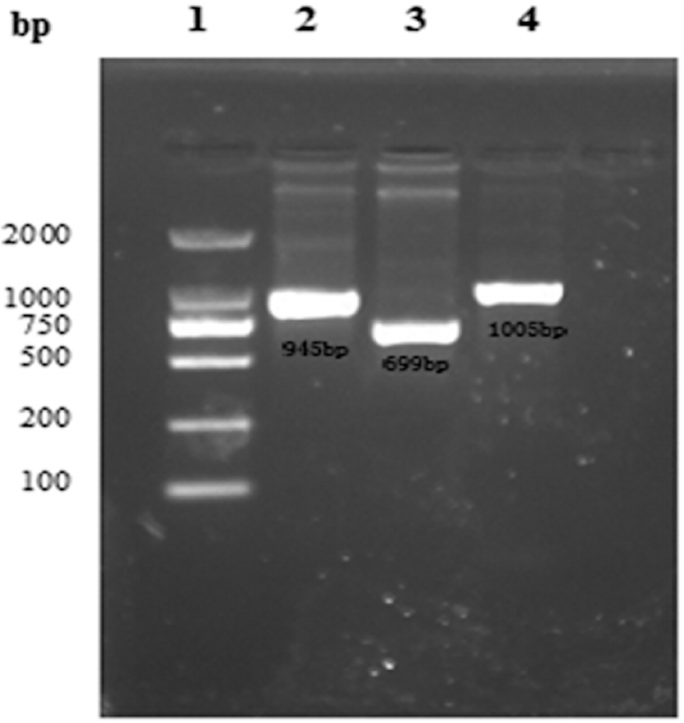
Fig 1. PCR results for the CSBV VP1 , VP2 , and VP3 genes. Lane 1, DNA marker DL2000; Lane 2, VP1 gene PCR products; Lane 3, VP2 gene PCR products; Lane 4, VP3 gene PCR